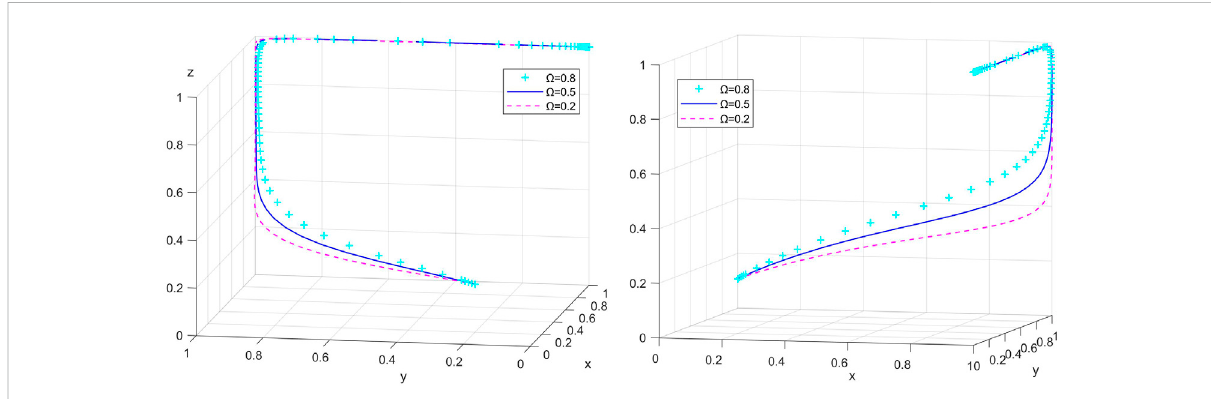
FIGURE 7 Impact of logistics companies on corporate